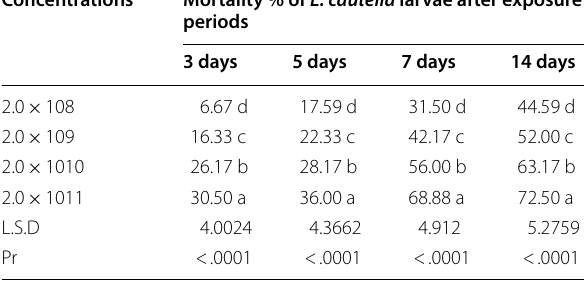
Mean in same column followed by the same letters is not significant L.S.D., least significant difference; Pr., probability level